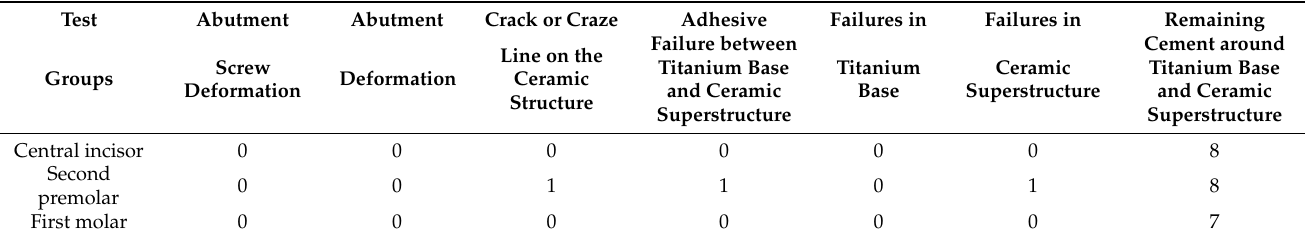
Table 1. Parameters analyzed after the loading and exposure in methylene blue dye solution. Number of registered incidents.